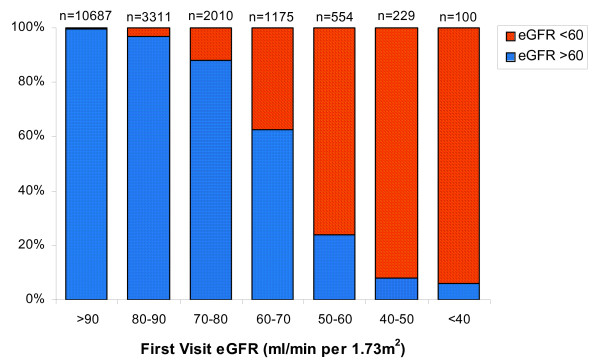
Proportion of individuals with eGFR < 60 mL/min per 1.73m2 or ≥ 60 mL/min per 1.73 m2 at their second study visit stratified by the initial eGFR. GFR is estimated using the CKD-EPI equation. The x-axis refers to the eGFR at the first study visit while the y-axis identifies the proportion of individuals with that initial eGFR who had a second visit eGFR above and below 60 mL/min per 1.73m2. 'n' refers to the number of participants in each eGFR group at the first study visit.